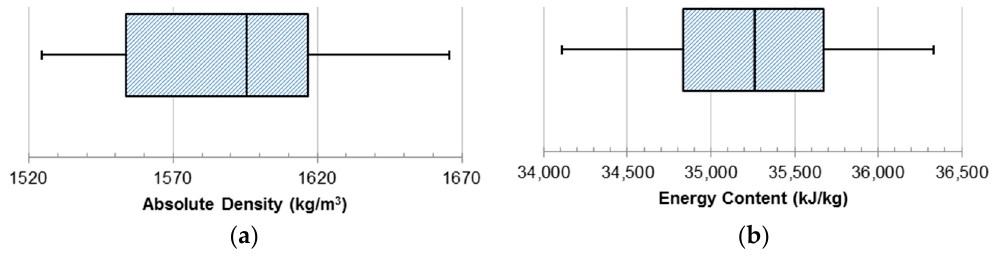
Figure 8. The distribution of measure values for ( a ) absolute density; and ( b ) energy content of the micronized charcoal particles. The box-and-whisker plot represents the minimum, first quartile, median, third quartile, and maximum values from left to right, respectively.